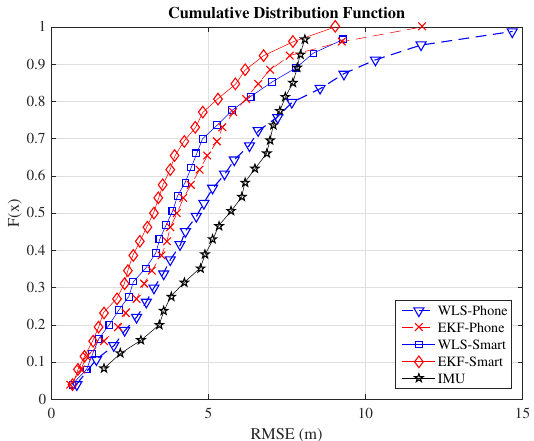
Figure 9. CDF of the positioning estimation error in Path 2.